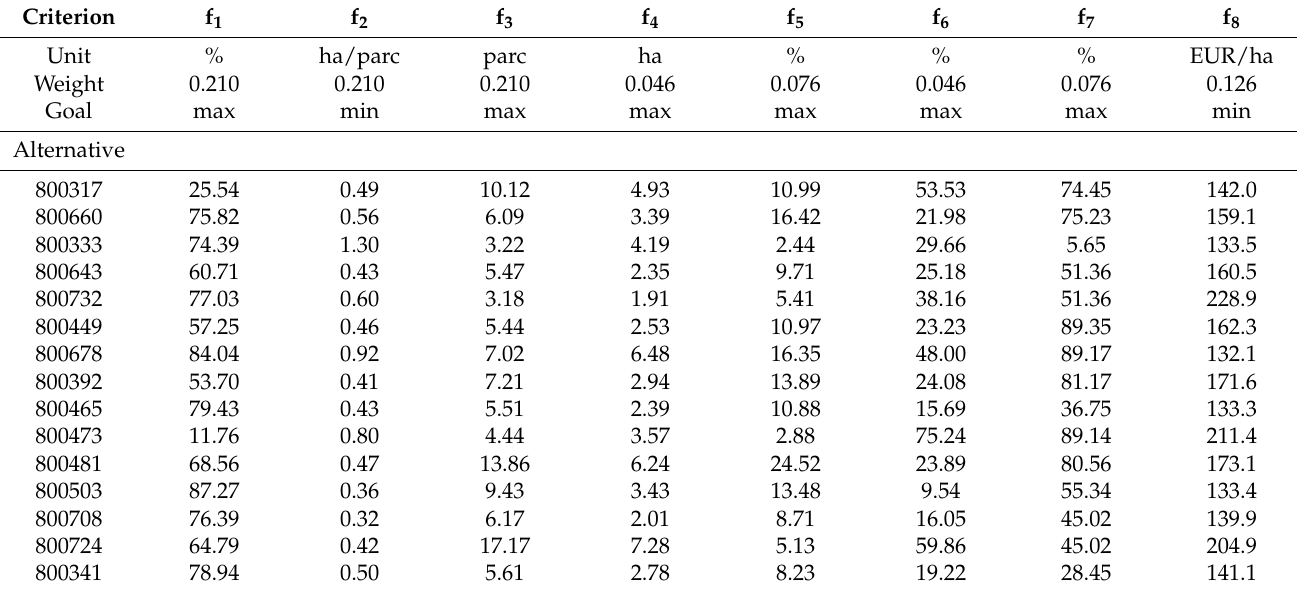
Table 8. Decision-making matrix case for eight criteria used.